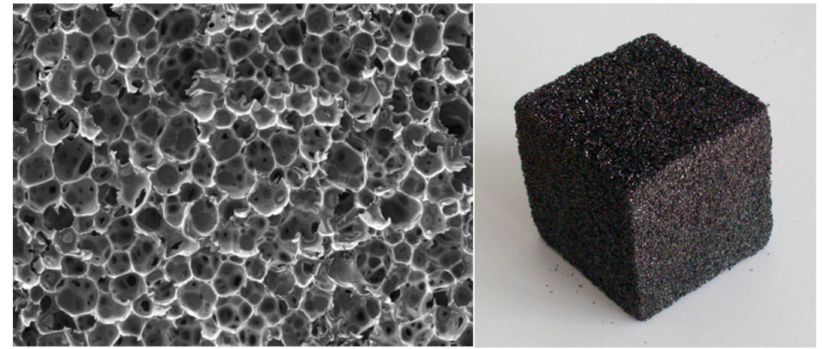
Figure 6. Scanning electron microscope image of the structure of a first-generation tannin–furanic foam ( left ) and macro-appearance of the same ( right